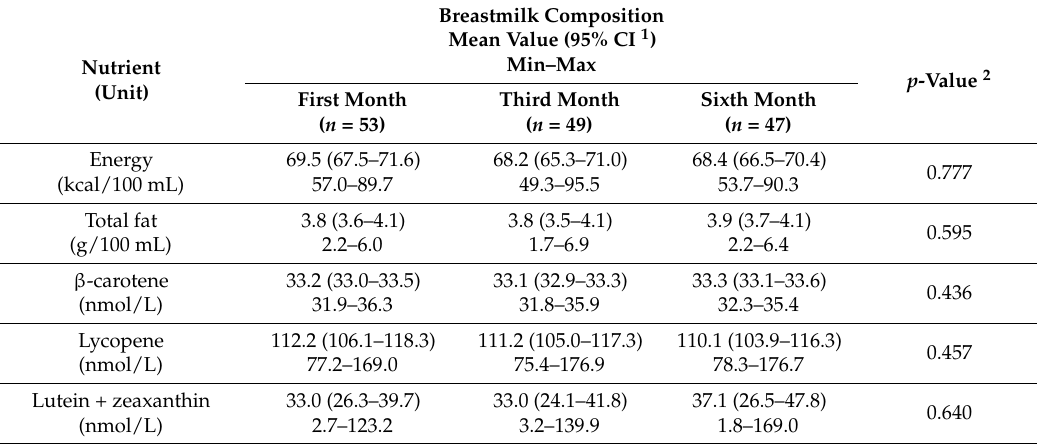
Table 2. Energy value, fat and carotenoid content in breastmilk in the first, third and sixth month of lactation.